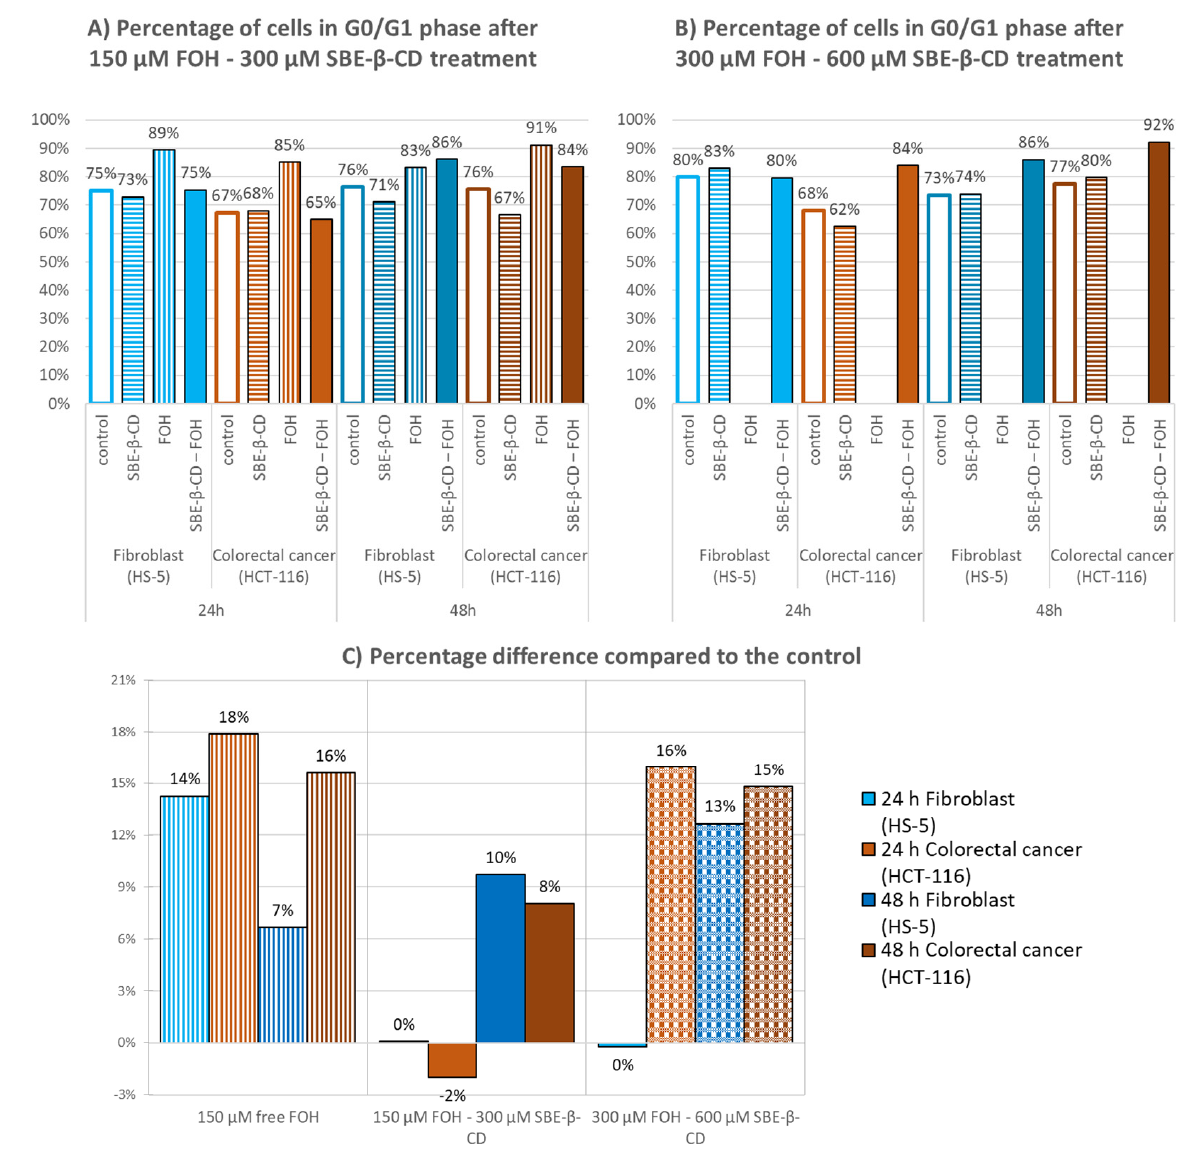
Figure 7. Percentage of cells in G0/G1 phase after treatment of fibroblast and colorectal cancer cells for 24 and 48 h; ( A ) Concentration of treatments is FOH 150 μ M and SBE- β -CD 300 μ M; ( B ) Concentration of treatments is FOH 300 μ M and SBE- β -CD 600 μ M. ( C ) Difference in the percentage of cells in G0/G1 phase compared to the control.